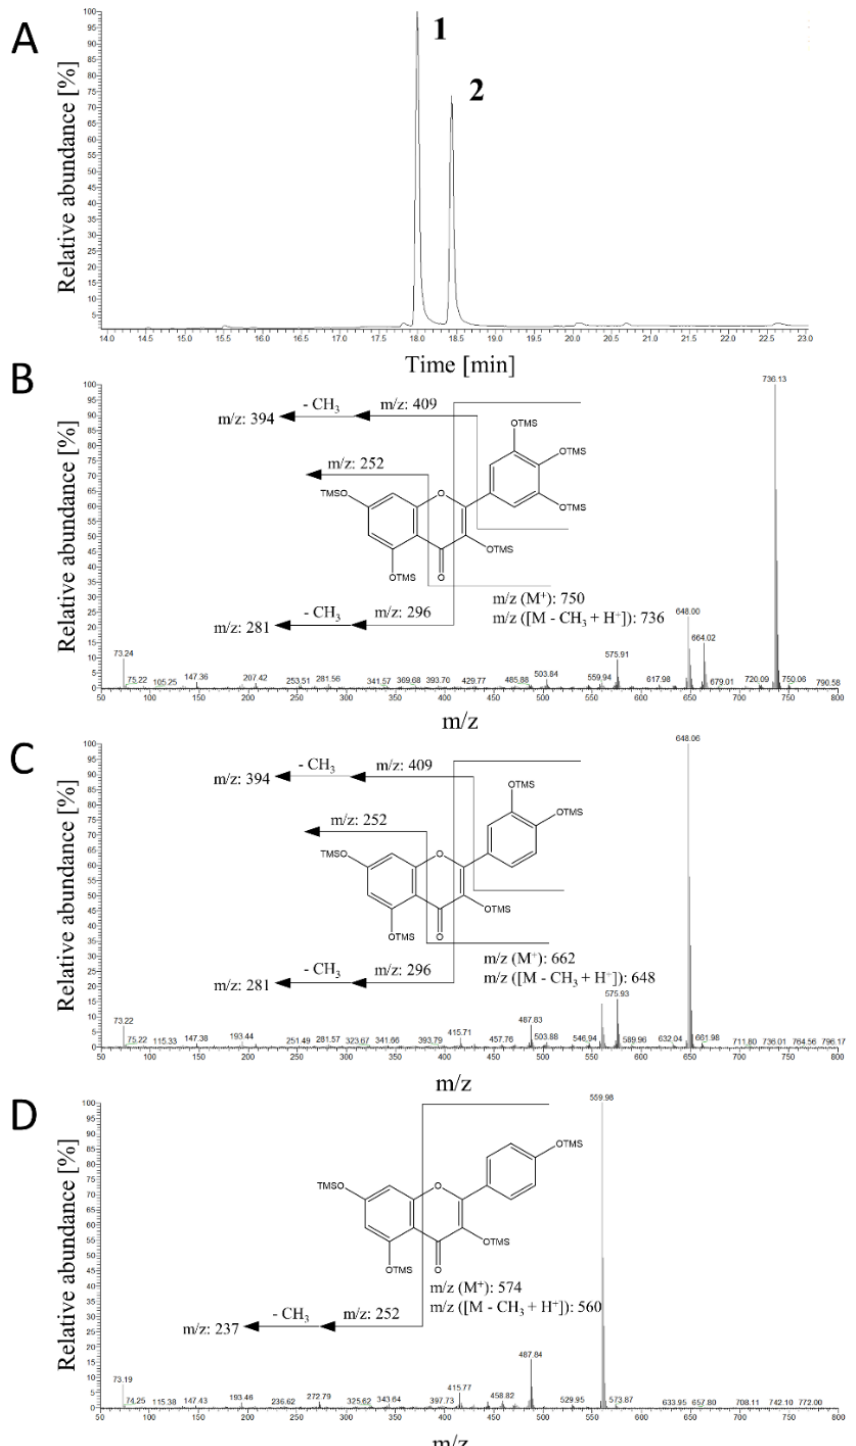
Figure 6. GC/MS analysis for identification of tyrosinase reaction products converted from kaempferol using Bm Ty. Two major products at RT = 18.0 min (product 1) and RT= 18.5 min (product 2) were detected, then they were identified as quercetin ( m / z = 662, product 1) and myricetin ( m / z = 750, product 2). ( A ) Gas chromatogram of the reaction sample. ( B ) MS spectrum of the prod- uct 2, myricetin. ( C ) MS spectrum of the product 1, quercetin. ( D ) MS spectrum of the standard compound of kaempferol.